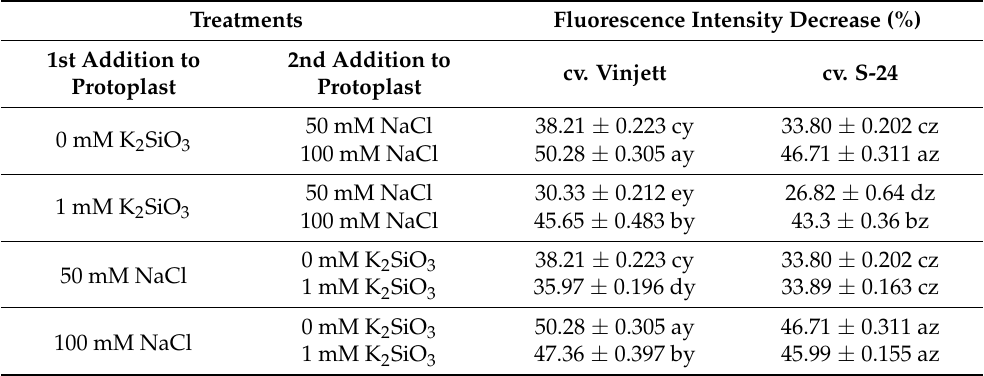
Table 1. Fluorescence intensity changes (%) in leaf protoplasts of cv. Vinjett and cv. S-24 loaded with chloride sensitive dye MQAE [N-(6-methoxy-quinolyl) acetoxy ester] upon addition of 1 mM K 2 SiO 3. Followed by the addition of 50 or 100 mM NaCl. Data are also shown for cases where 50 or 100 mM NaCl addition was followed by the addition of 1 mM K 2 SiO 3 to the protoplasts of both cultivars. Letters (a–e) indicate significant differences ( p ≤ 0.05) in fluorescence intensity after different salt treatments with and without K 2 SiO 3. Letters (y–z) represent significant ( p ≤ 0.05) difference in fluorescence intensity between cv. Vinjett and cv. S24 receiving the same treatment. A higher fluorescence decrease means a higher chloride concentration. Means ± SE. n = 10. Treatments Fluorescence Intensity Decrease (%) 1st Addition to 2nd Addition to cv. Protoplast Protoplast